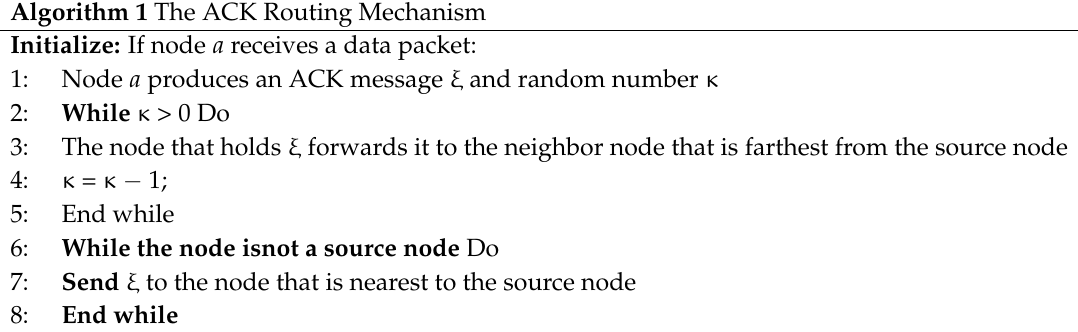
Algorithm 1 The ACK Routing